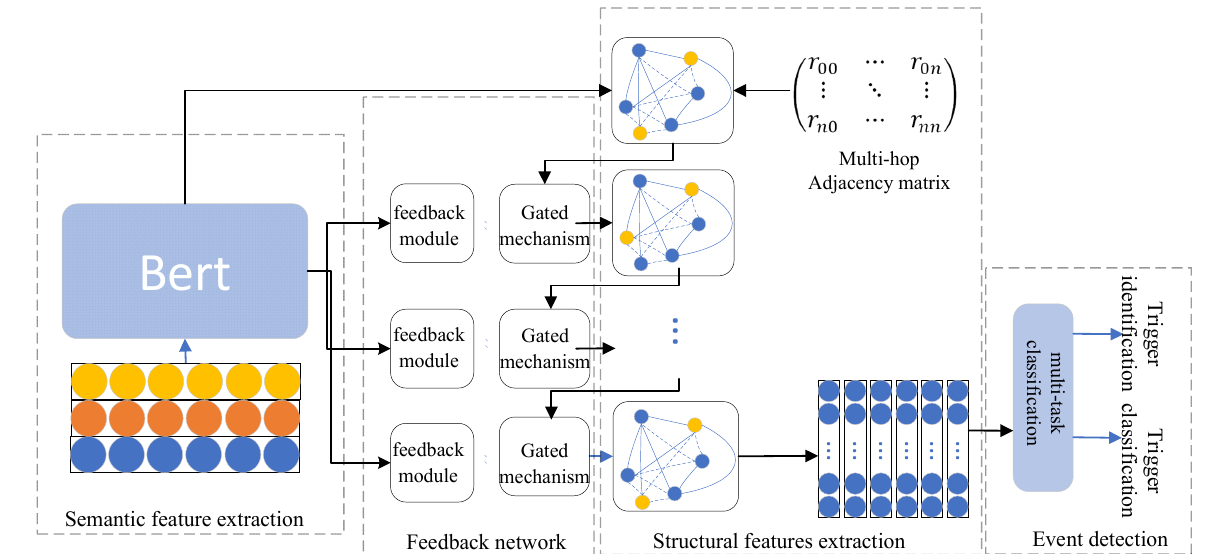
Figure 1. Illustration of the MHG-SMFB architecture.